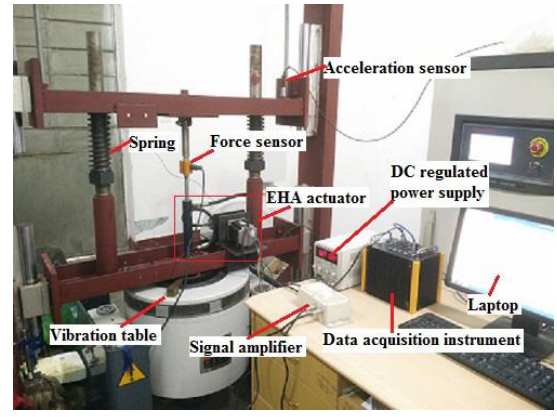
Figure 4. Force characteristic test of the EHA semi-active suspension system.